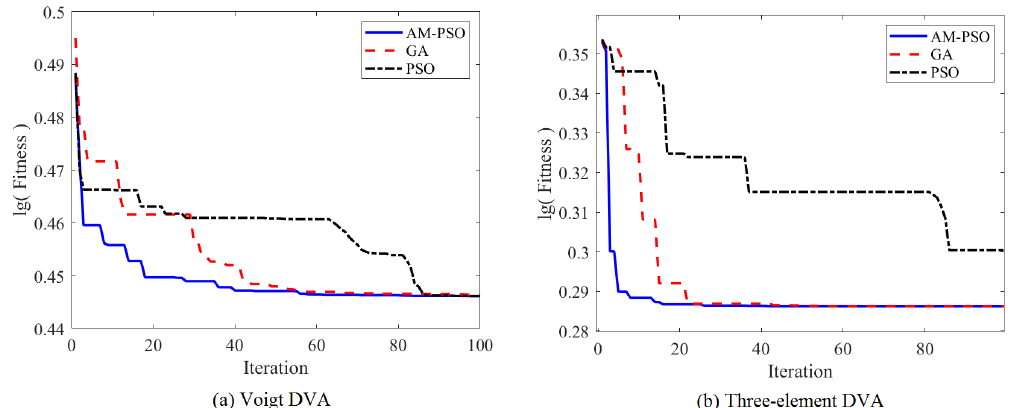
Figure 4. Convergence of PSO, AM-PSO, and GA algorithms.